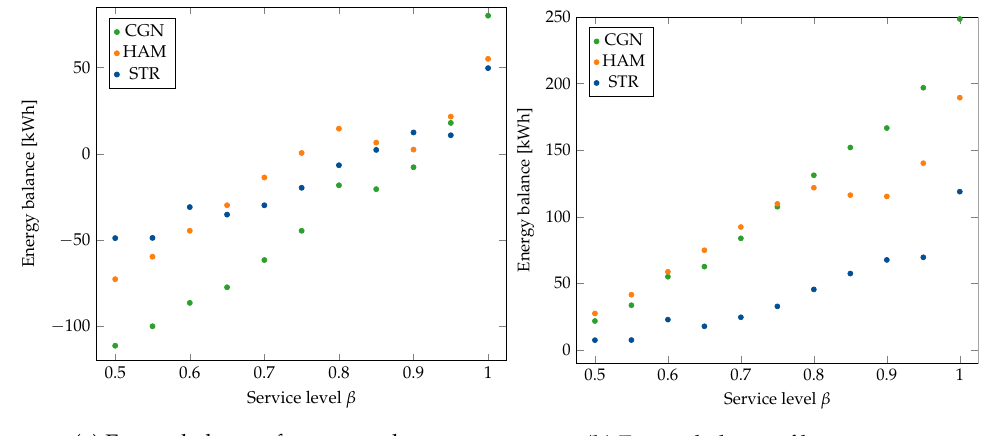
Figure 11. Energy balance for different service